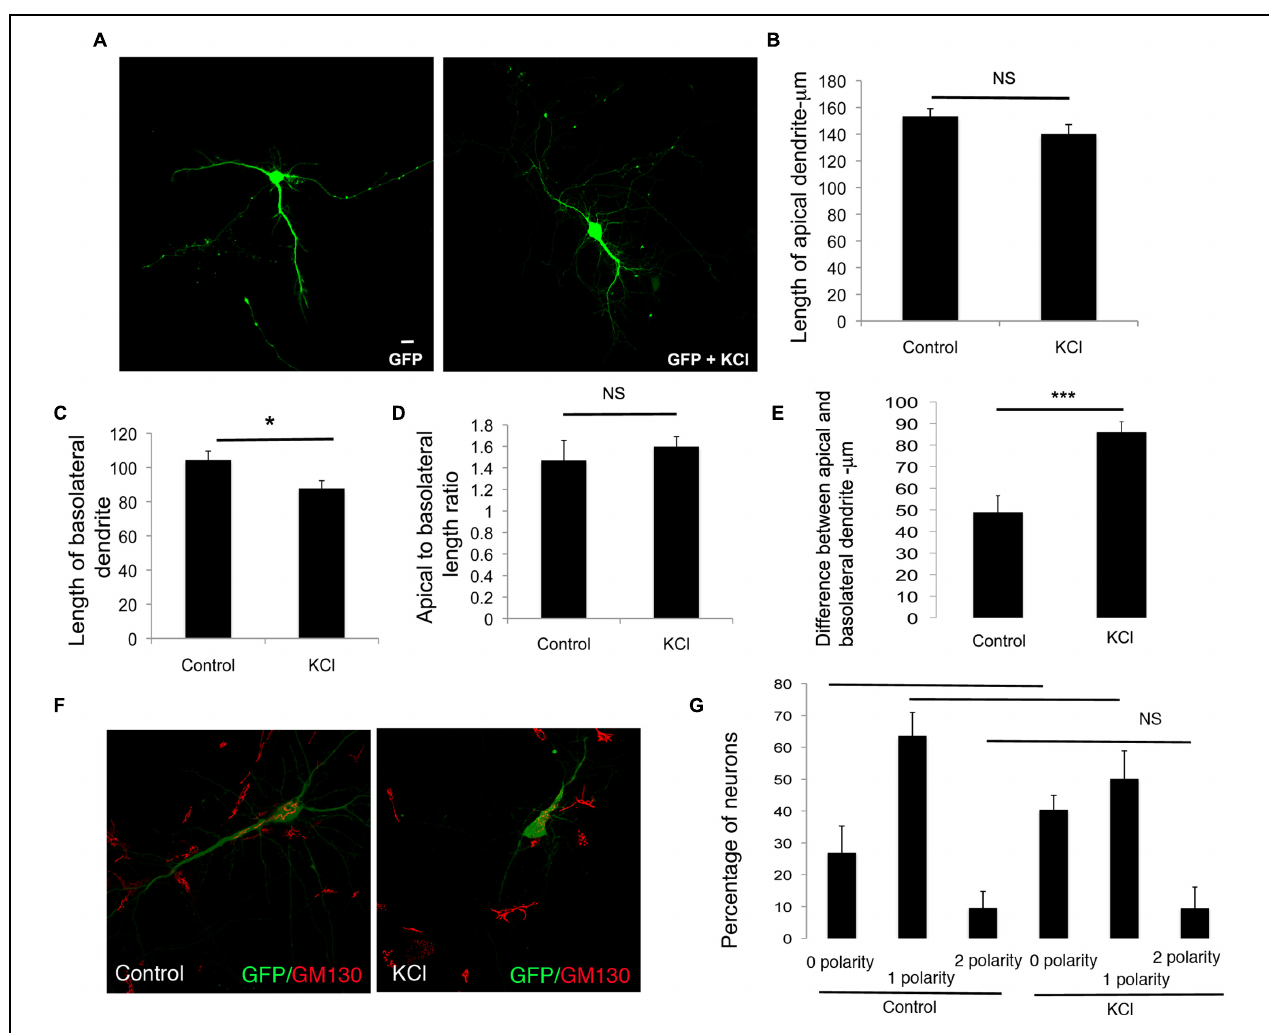
FIGURE 5 | Enhancing global neuronal activity suppresses net extension of basolateral dendrite extension in developing neurons. (A) Representative confocal images of neurons transfected with GFP and treated with or without KCl. (B) Length of apical dendrite. (C) Length of basolateral dendrite. (D) Ratio of lengths of apical to basolateral dendrites, and (E) Total dendritic length in neurons expressing GFP chronically treated without or with KCl at DIV 7. (Error